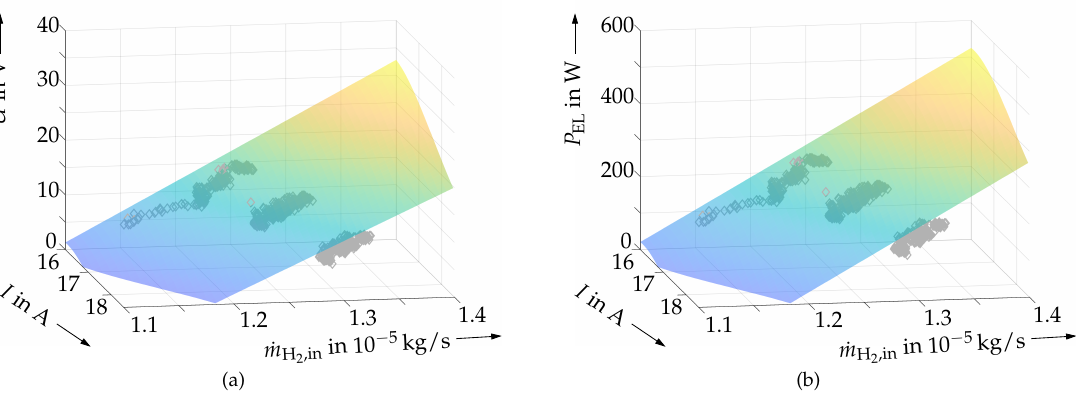
Figure 6. Offline identification of the current–voltage and current–power characteristic for larger, temporally varying hydrogen mass flows ˙ m H . ( a ) Fuel cell voltage depending on the terminal 2 ,in current and hydrogen mass flow. ( b ) Fuel cell power depending on the terminal current and hydrogen mass